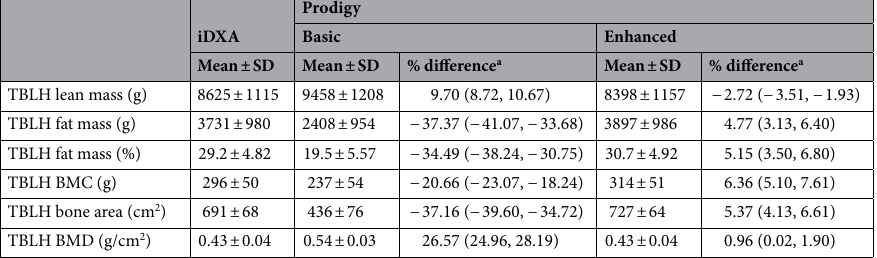
Prodigy scans using enhanced analysis, there remained differences between the iDXA and the Prodigy, except for TBLH BMD (− 0.004 g/cm 2 [95% CI − 0.009, 0.001], p = 0.131), and some regional estimates (Supplementary Table S1). When expressed as percentage differences, Prodigy basic TBLH values were up to 37% different from those obtained on the iDXA (Table 2). Differences were largest for fat mass (kg and %) and bone parameters (BMC, bone area, and BMD), as well as for regional estimates, which were up to 65% different (Table 2 and Supplementary Table S1). When Prodigy scans were reanalysed using enhanced analysis, the percentage differences reduced to < 6.5% for TBLH values and < 15.5% for regional estimates (Table 2 and Supplementary Table S1). The Bland–Altman analyses are reported in Tables 3 and Table S1 and Supplementary Fig. S1. Compared to the iDXA, Prodigy basic LM was higher by ~ 800 g and FM lower by ~ 1.3 kg, resulting in a difference in total mass of − 550 g and a difference in %BF of − 9.7%. Both bone area and BMC were reduced (− 255 g [95% LOA − 329, − 181] and − 59 [95% LOA − 86, − 32], respectively), although bone area to a greater extent, resulting in greater estimates of BMD (+ 0.11 g/cm 2 [95% LOA 0.09, 0.13]). A systematic bias for %BF was observed, with differences being greater among those with low %BF. When the Prodigy scans were reanalysed using enhanced analysis, the bias for TBLH LM reduced to less than 250 g, while the bias for FM reduced to almost a tenth of the original value (+ 167 g [95% LOA − 133, 466]). Meanwhile, the bias for BMD was reduced to 0 g/cm 2 . Regional analyses paralleled the TBLH results, with the Prodigy basic having higher LM but lower FM and bone area. Reanalysis of Prodigy files with enhanced analysis attenuated these differences. Adjustment equations. Prediction equations were developed to enable adjustment of Prodigy (basic) measurements (Table 4 and Fig. 1). Prediction equations for enhanced measurements are contained within the supplementary file (Supplementary Table 2 and Supplementary Fig. S2).